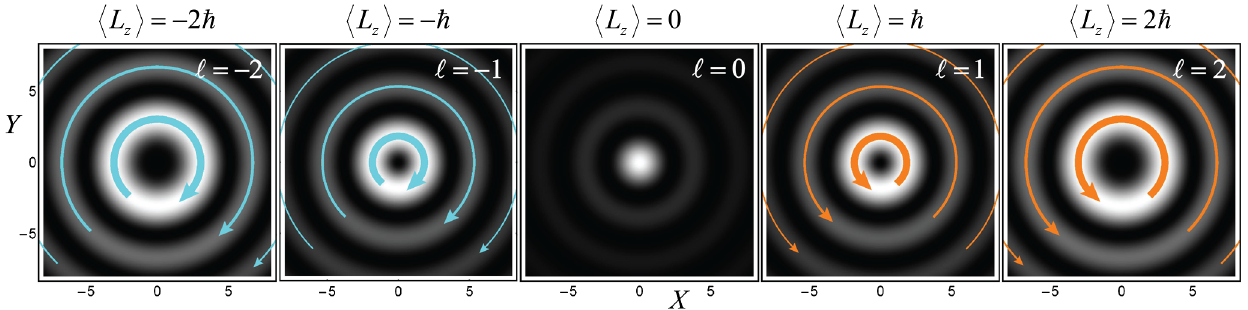
FIG. 2. Transverse probability-density distributions and azimuthal currents, Eqs. (9), for free-space Bessel beams (7) with different OAM quantum numbers ‘ . The dimensionless coordinates X ¼ (cid:3)x and Y ¼ (cid:3)y are used. Here and in the following figures, the radii and thicknesses of the current circles correspond to the positions and values of the maxima (normalized in each panel independently) that determines the contribution to the kinetic OAM, Eq. of the quantity rj ’